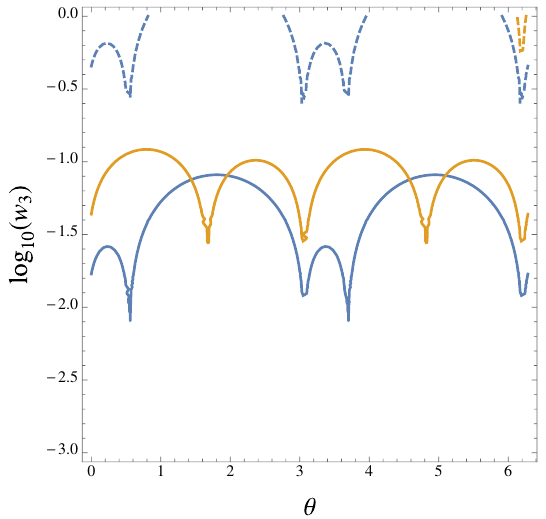
Figure 17. The (cid:12)gure shows the current (solid) and expected [126] (dashed) limits from muon- electron conversion in nuclei in the (cid:18) { w 3 plane for normal mass ordering (blue) and inverted ordering (orange). The region below each curve is ruled out. The dips at (cid:18) (cid:25) 3 : 08 and (cid:18) (cid:25) 6 : 22 stretch to negative in(cid:12)nity. Aside from accidental cancellation, the values (cid:18) (cid:25) 3 : 08 ; 6 : 22 ensure that the coupling to the electron vanishes. Only real values of (cid:18) are